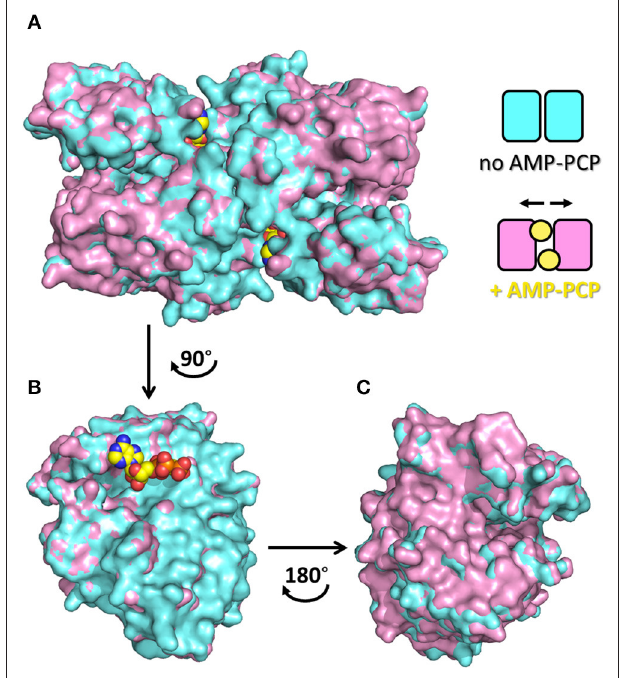
FIGURE 5 | Quaternary rearrangement of spSR upon binding of AMP-PCP with enlargement of the groove between the two monomers. (A) Surface representation of spSR in the open form in the presence (PDB 1WTC, pink) and absence (PDB 1V71, cyan) of AMP-PCP bound to two symmetric sites at the dimer interface. The scheme indicates the changes in the relative position of the monomers in the two conditions, i.e., without or with AMP-PCP. In order to highlight the quaternary changes caused by AMP-PCP, the superposition of only one monomer is shown (B) facing the direction of the dimer interface, upon rotation of 90 ◦ of the dimer, and (C) from the opposite side of the subunit, upon rotation of 180 ◦ of the monomer, i.e. rotation of the dimer of 90 ◦ in the opposite direction. AMC-PCP is in yellow. In (B) , only the molecule of AMP-PCP bound to the monomer is